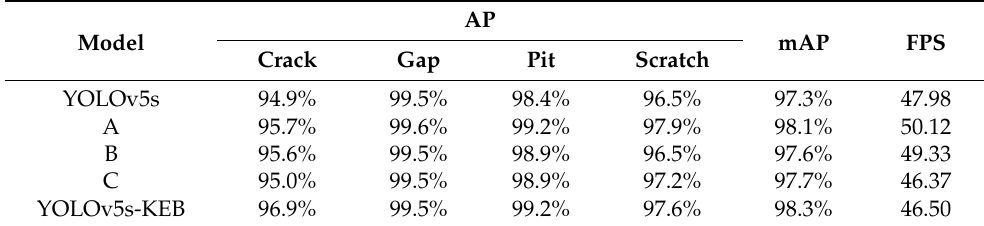
Table 4. Comparison of evaluation indicators for each model.